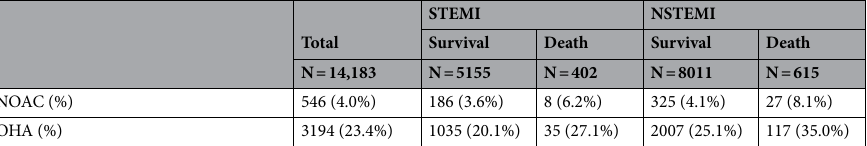
Table 1. Characteristics of the study population. Abbreviations: ACEi, angiotensin-converting enzyme inhibitor; AMI, Acute Myocardial Infarction; ARB, angiotensin receptor blocker; BB, beta-blocker; CCB, calcium channel blocker; NOAC, non-vitamin K antagonist oral anticoagulants; OHA, oral hypoglycemic agent; STEMI, ST-segment elevation Myocardial Infarction; NSTEMI, Non-ST-segment elevation Myocardial Infarction. *The proportion of the medication prescribed at hospital discharge in the death group was calculated after excluding the in-hospital mortality but before excluding patients with missing information during hospital admission: 129 and 334 for the death group in STEMI and NSTEMI,